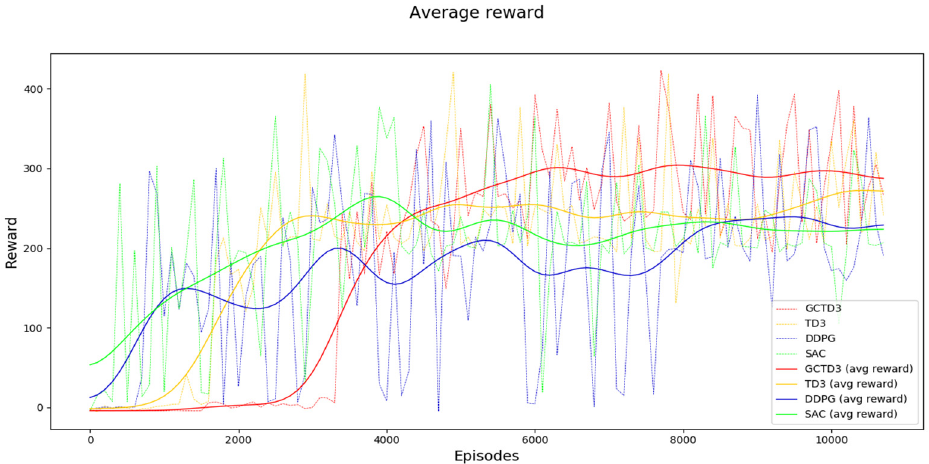
Figure 8. Cumulative reward over 10,000 episodes when training GCTD3 (red), TD3 (yellow), DDPG (green) and SAC (blue).